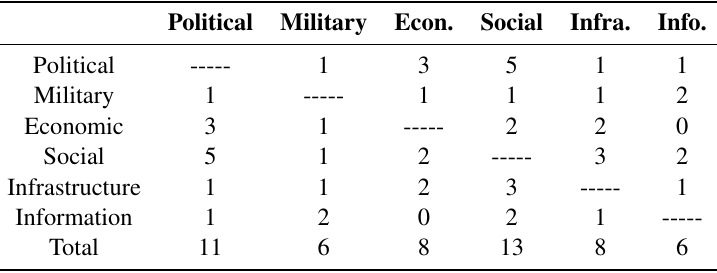
Summary of role-based identification of critical